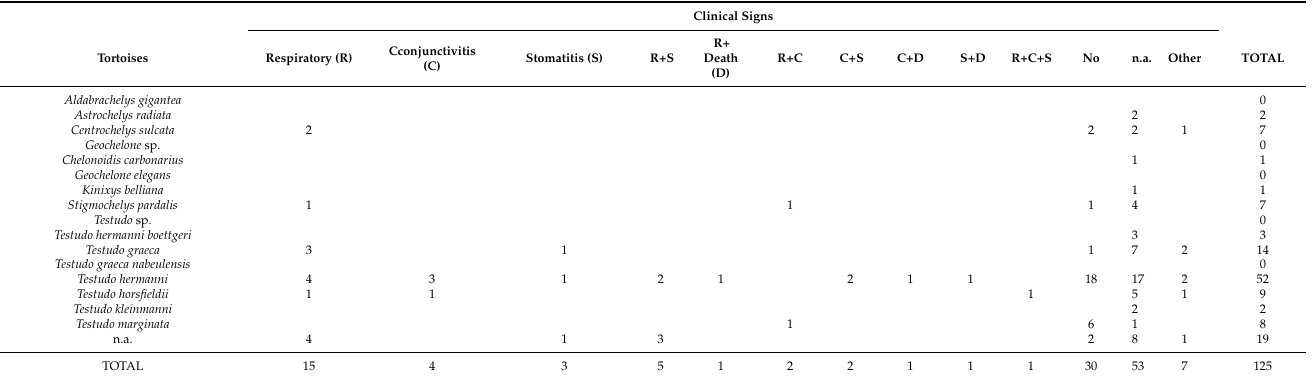
Table 3. Clinical signs observed in different species of tortoise resulted negative for Mycoplas- mopsis agassizii by PCR. Legend: R = respiratory, C = conjunctivitis, S = stomatitis, D = death, No = asymptomatic, n.a. = not available, Other = showing diseases different than those reported in the previous